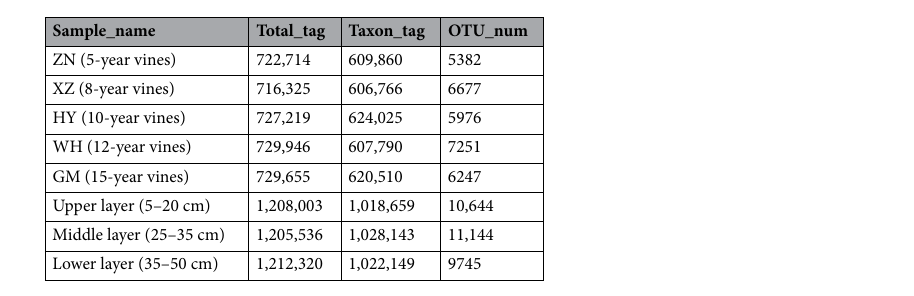
Table 4. Sequence number and OTU number of soil samples in the terms of soil depth and grape planting